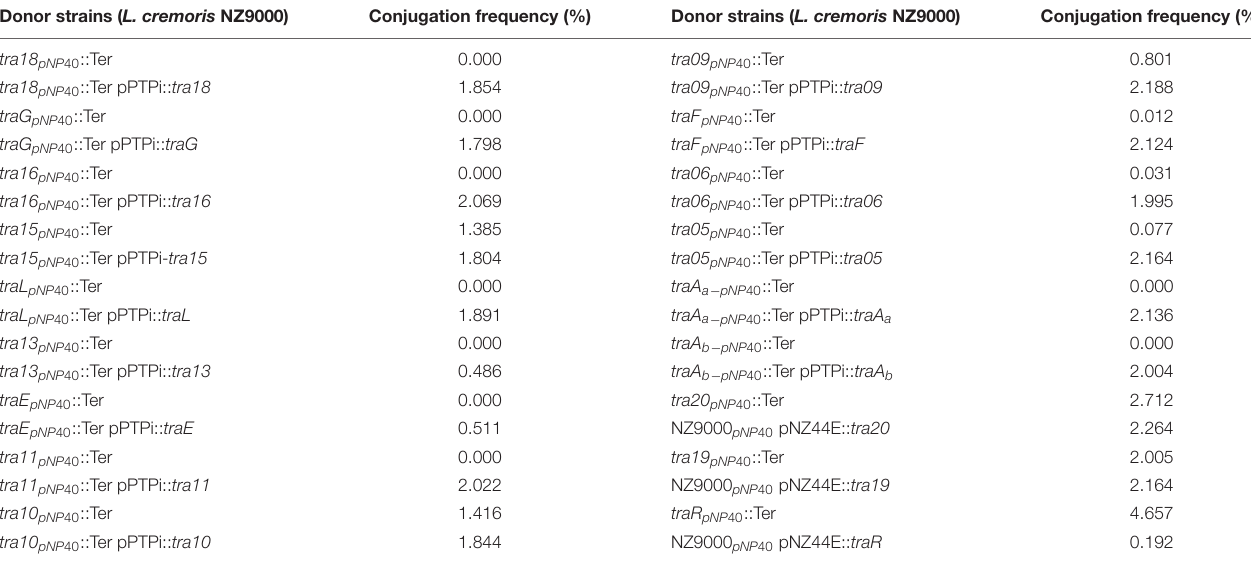
TABLE 4 | Complementation and overexpression conjugation